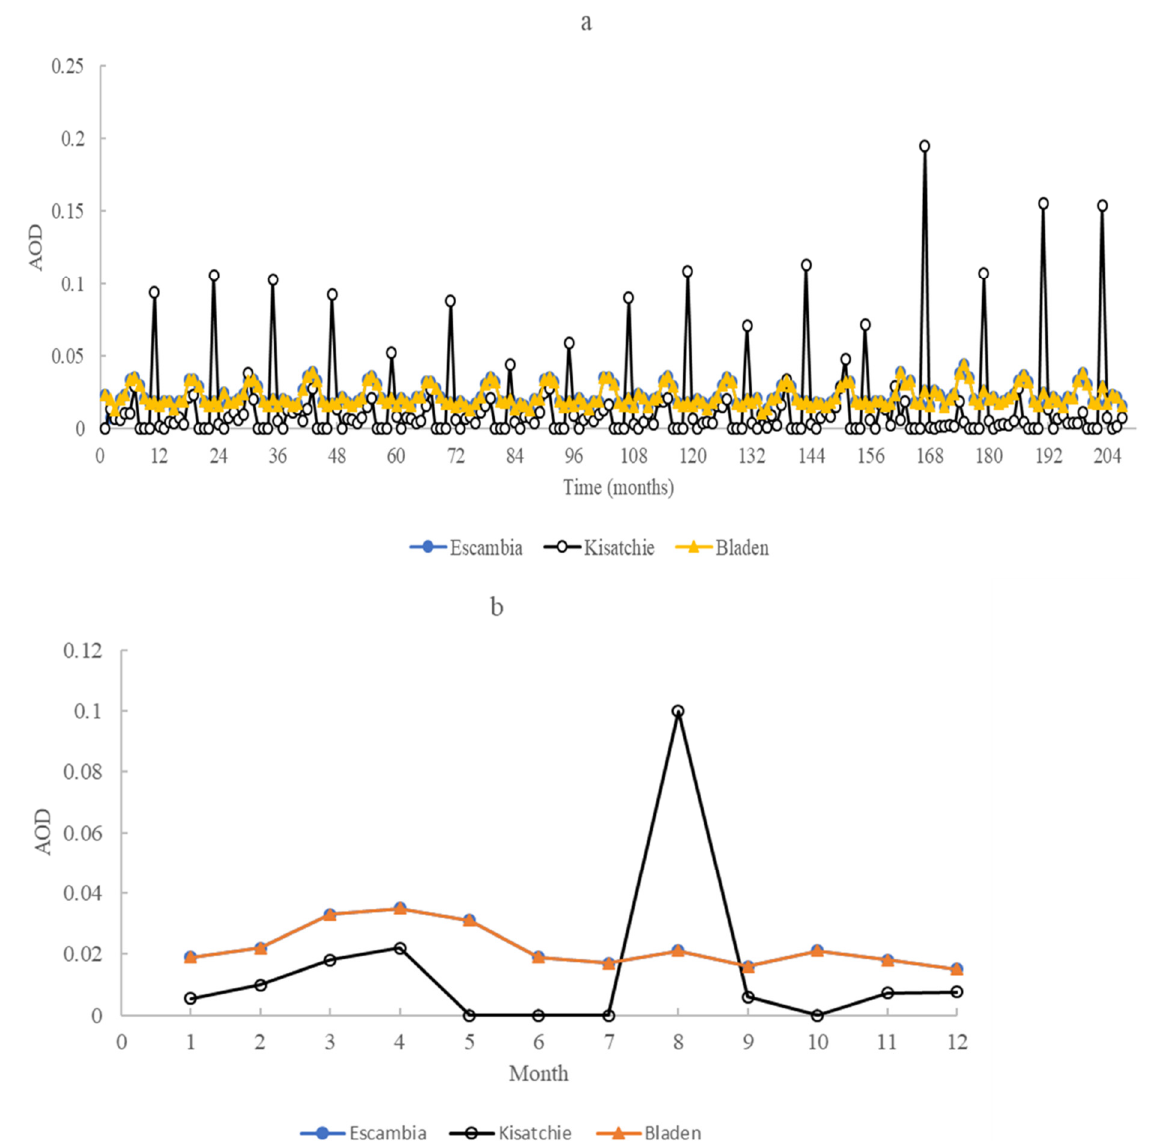
Figure 1. Dynamics of aerosol optical depth (AOD) at 483.5 nm in Escambia, Bladen, and Kisatchie ( a ) Monthly and yearly dynamics of AOD from October 2004; ( b ) The integrated monthly average of AOD.